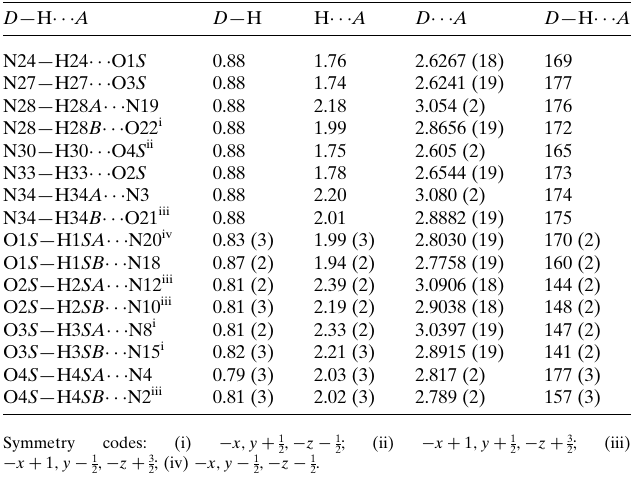
Table 5 Hydrogen-bond geometry (A˚ , (cid:4) ) for 5